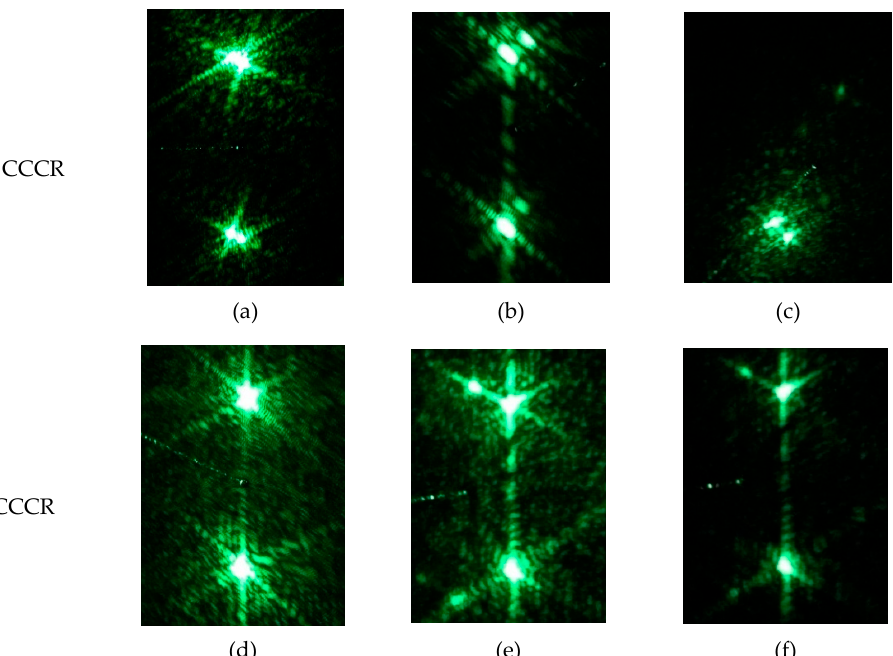
Figure 21. The light distribution for a 0 ◦ incident light beam on anterior, central and posterior regions of the commercial CCCRs, which are shown in ( a )–( c ) respectively, and those of the optimized SuperPin CCCR are shown in ( d )–( f ).